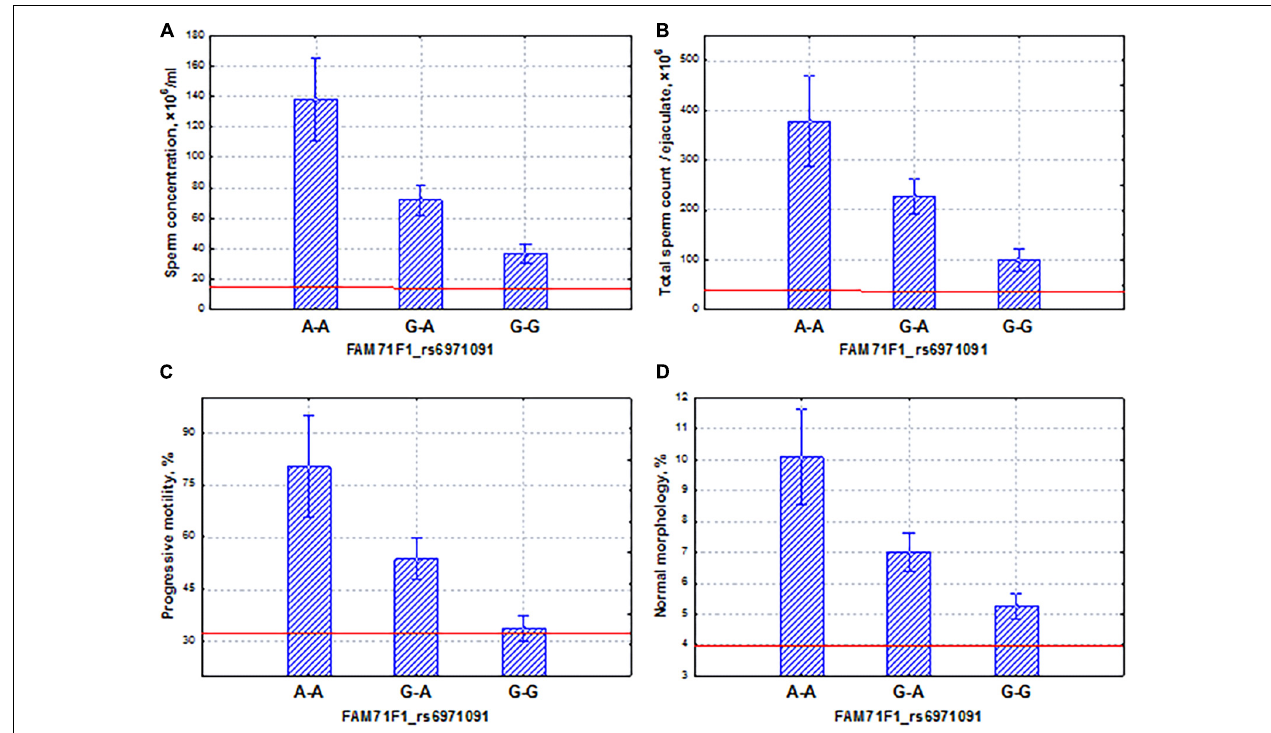
FIGURE 6 | Coordinated allelic effects of the SNP marker rs6971091 of the FAM71F1 gene on semen quality parameters. (A) Sperm concentration, (B) total sperm count, and (C) proportion of motile, and (D) morphologically normal sperm. All the allelic differences were highly significant ( p < 0.0025). The red lines indicate the WHO reference limits for different normal semen parameters [World Health Organization (WHO),